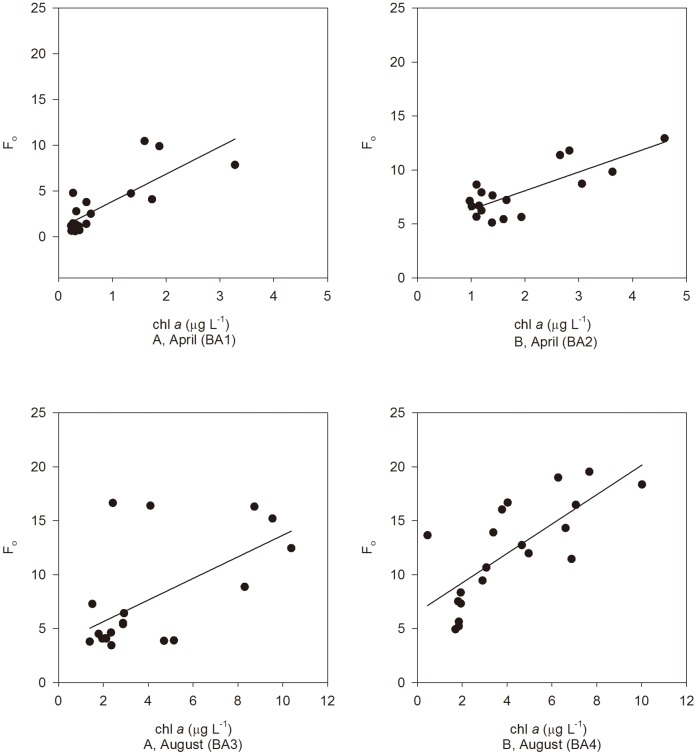
Linear relationship between Fo and chl a concentration (µg L−1) after 48 hrs incubation in different bioassays.R2 = 0.6216, p<0.001 in BA1, R2 = 0.6202, p<0.05 in BA2, R2 = 0.3503, p<0.01in BA3 and R2 = 0.5488, p<0.05 in BA4.